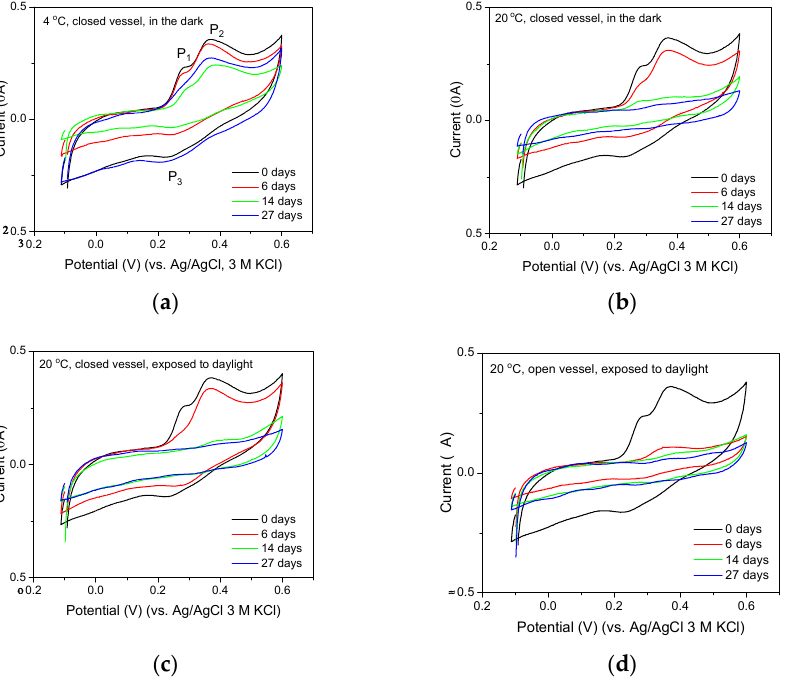
Figure 8. Cyclic voltammograms recorded in 20 times diluted green tea extracts (GT1) stored at ( a ) 4 ° C or ( b – d ) 20 ° C, in ( a – c ) sealed or ( d ) opened vessels, ( c , d ) exposed to daylight, or ( a , b ) kept in the dark. CVs recorded using GC n /PDMS electrode in 0.1 acetate buffer (pH = 4.5) with a scan rate of 50 mV/s. Table 2. Summary of physicochemical and electrochemical parameters of